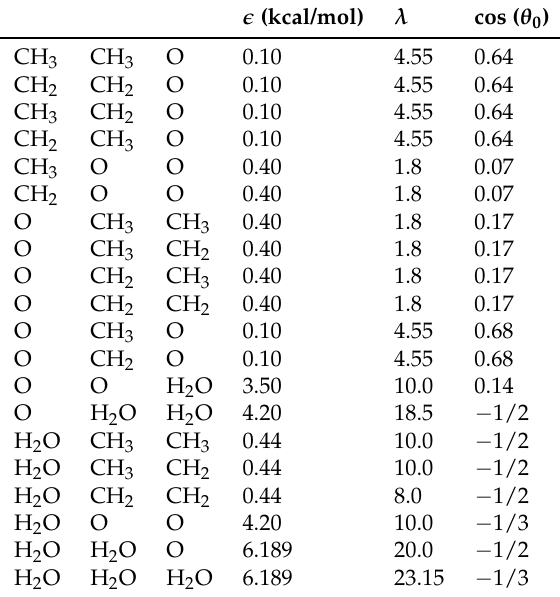
Table 2. Three-body potential parameters for ether and previously published parameters for water [19]. The central atom is given